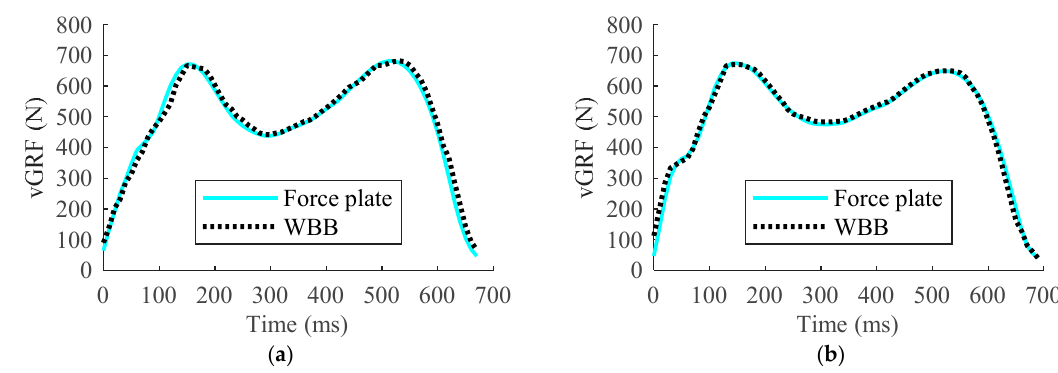
Figure 3. Vertical ground reaction force (vGRF) measured from the Nintendo Wii Balance Board (WBB) and the force plate in a stance while ( a ) walking straight (right foot—RF), and ( b ) walking along a curved path in a clockwise (CW) direction (RF (IN—inside foot turning)).